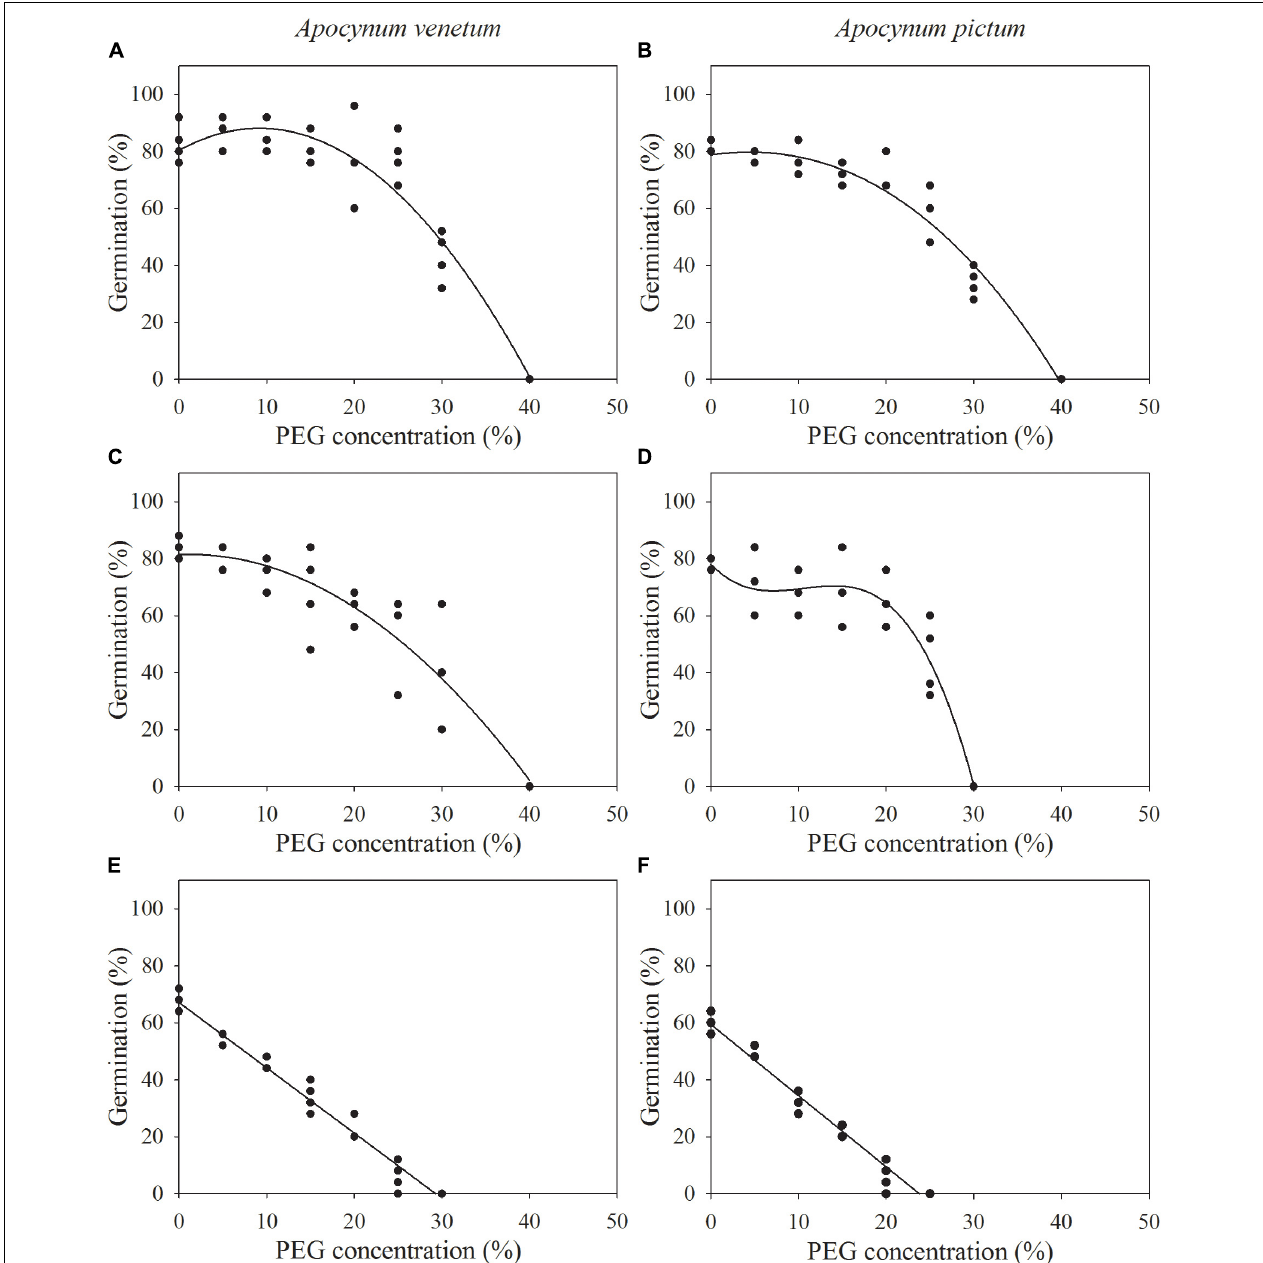
FIGURE 4 | Relationship between germination percentages of Apocynum venetum and Apocynum pictum seeds stored for 0 year (A,B) , 1 year (C,D) , and 2 year (E,F) and PEG concentrations.